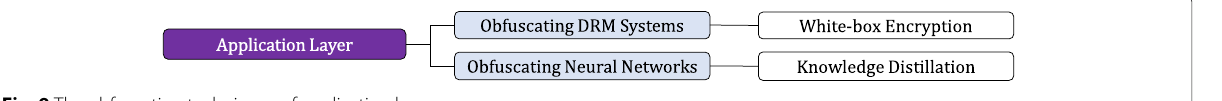
Fig. 9 The obfuscation techniques of application